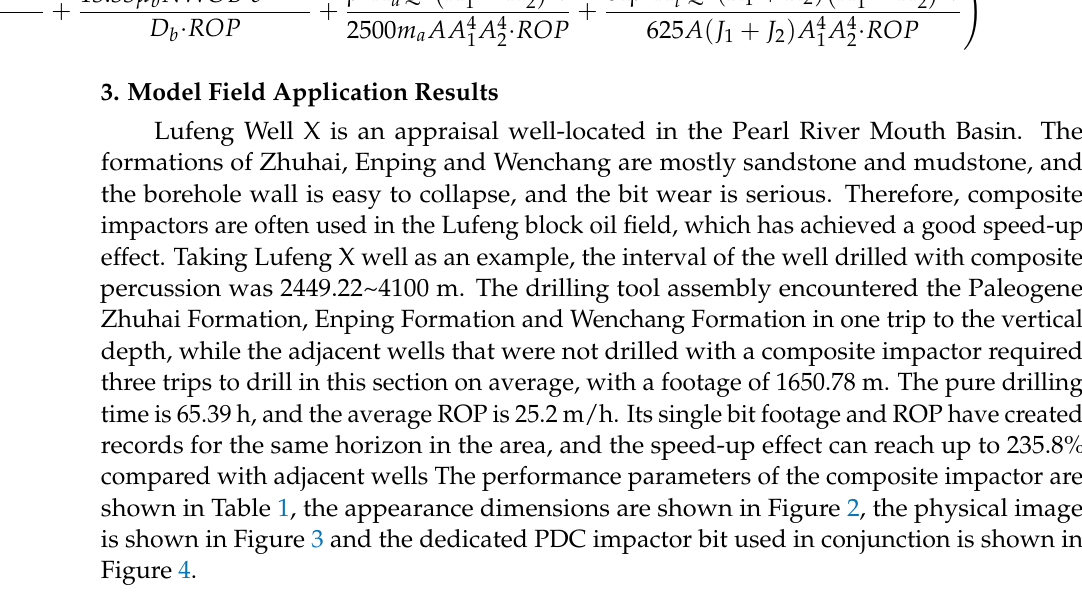
Table 1. Specifications and parameters of the compound